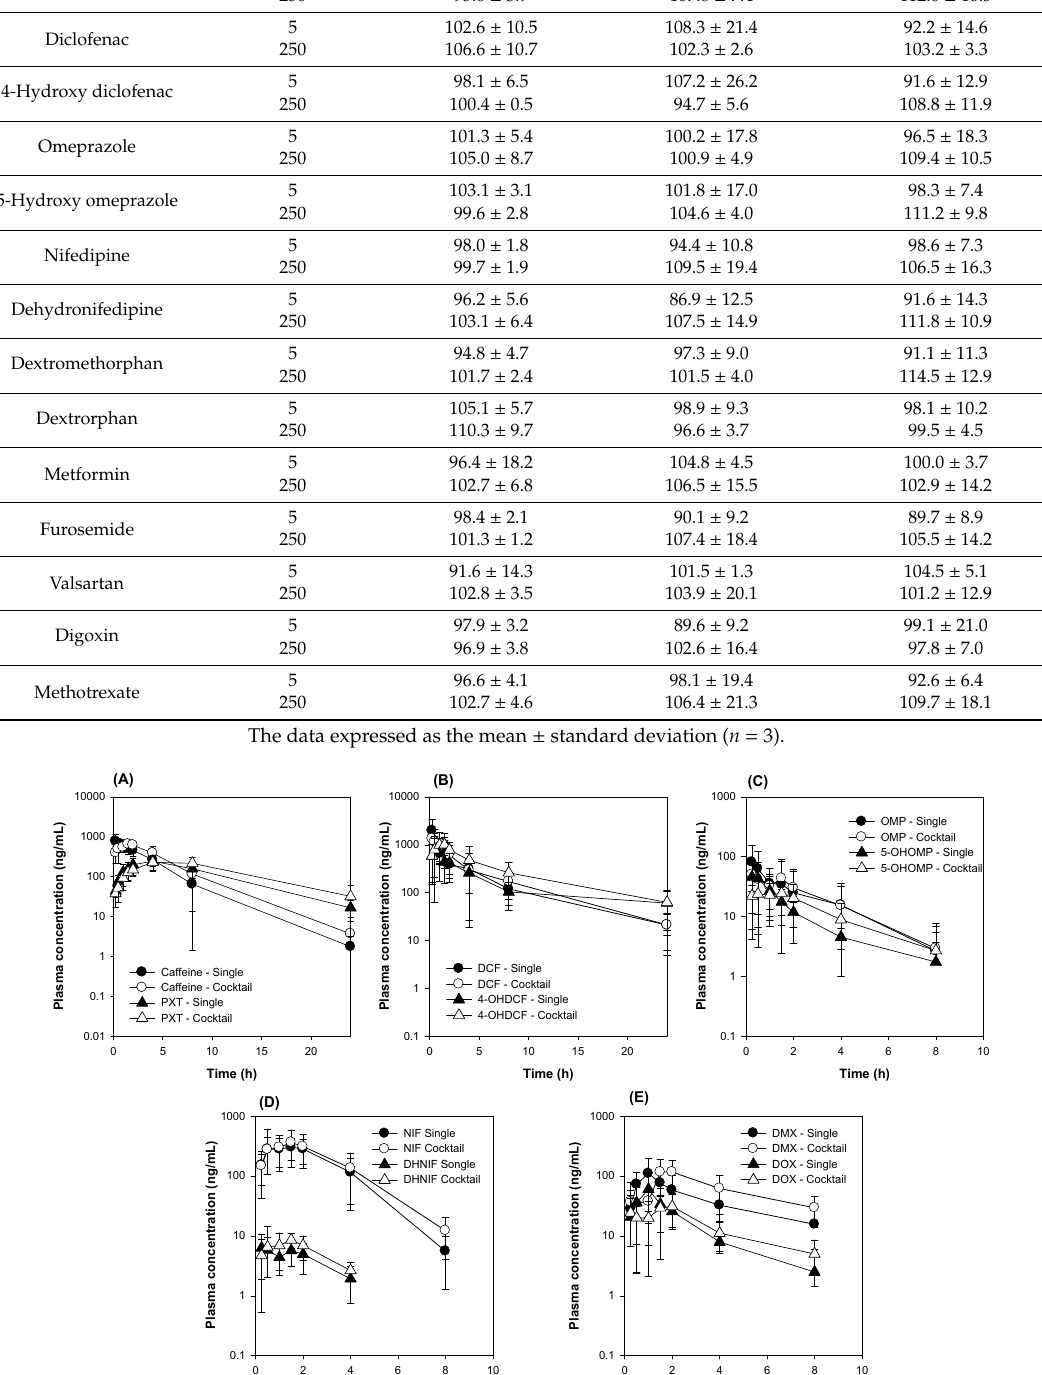
Figure 3. The plasma concentrations of ( A ) caffeine and paraxanthine (PXT), ( B ) diclofenac (DCF) and 4-hydroxy diclofenac (4-OHDCF), ( C ) omeprazole (OMP) and 5-hydroxyomeprazole (5-OHOMP), ( D ) nifedipine (NIF) and dehydronifedipine (DHNIF), and ( E ) dextromethorphan (DMX) and dextrorphan (DOX) following the single (closed symbol) and CYP cocktail (open symbol) oral administration of caffeine (1 mg/kg), diclofenac (2 mg/kg), omeprazole (2 mg/kg), nifedipine (0.5 mg/kg), and dextromethorphan (10 mg/kg) in rats. The data is expressed as the mean ± SD ( n = 6). Table 5. The comparison of pharmacokinetic parameters between single and CYP cocktail groups. Cyps